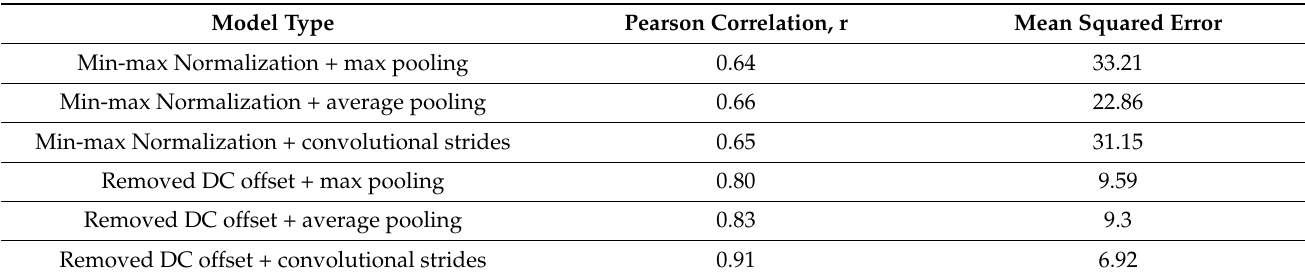
Table 3. Correlation between SVV derived from our CNN models with pre-processing and dimension reduction changes from the input variable and SVV from the commercialized model as a reference.